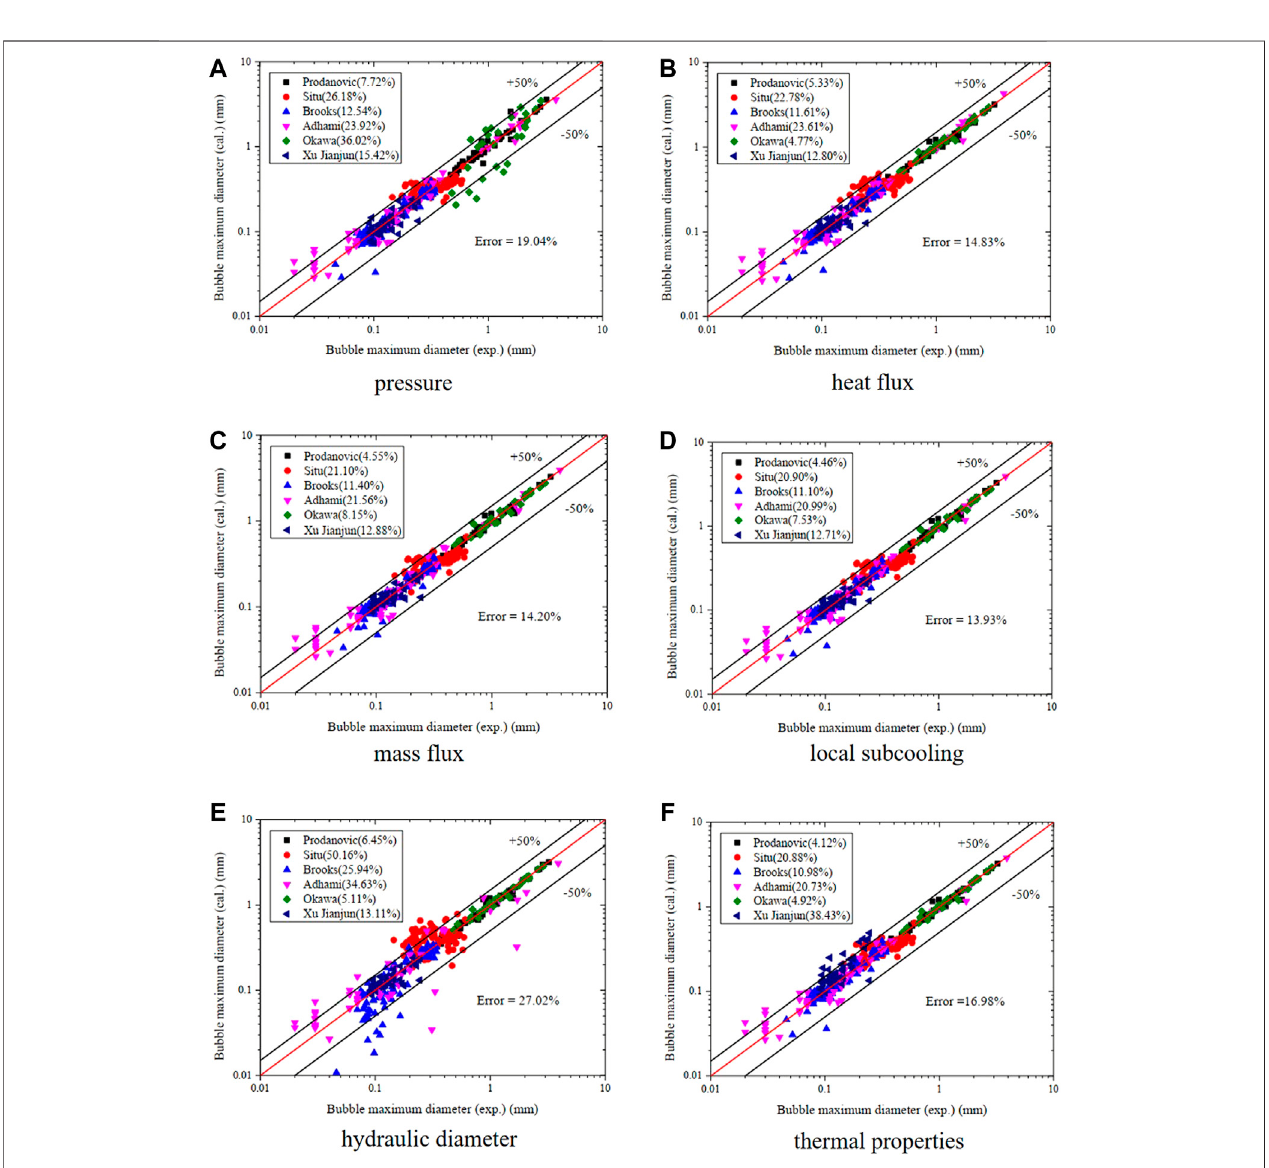
FIGURE5| ResultsoftheANNmodelunderthe fl uctuationsofexperimentalconditions. (A) Pressure, (B) heat fl ux, (C) mass fl ux, (D) localsubcooling, (E) hydraulic diameter, (F) thermal properties.